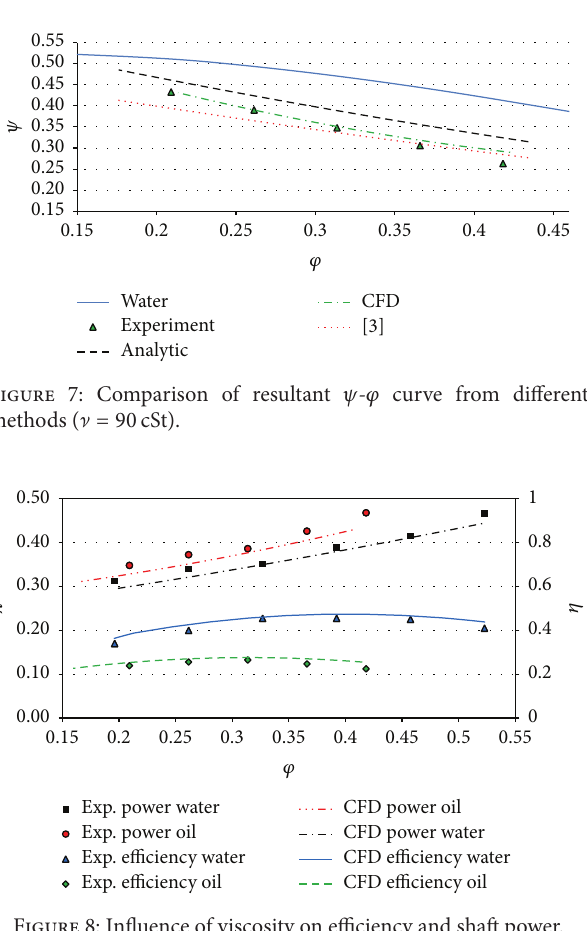
Figure 8: Influence of viscosity on efficiency and shaft power.